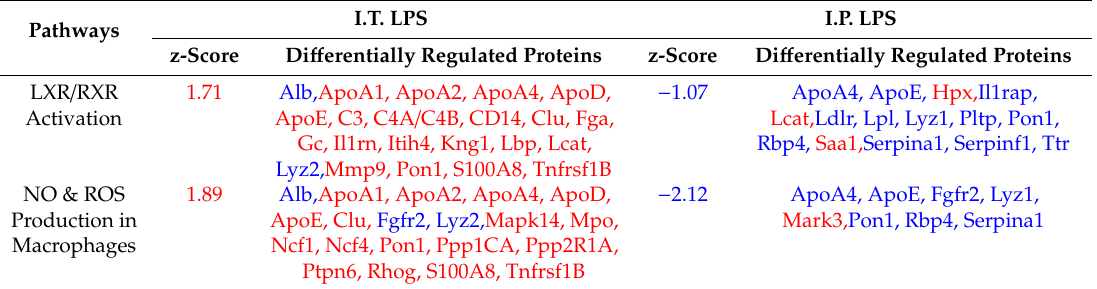
Table 2. Di ff erentially regulated BALF proteins in the LXR / RXR activation and production of NO and ROS in macrophages pathways by I.T. and I.P. LPS compared to the